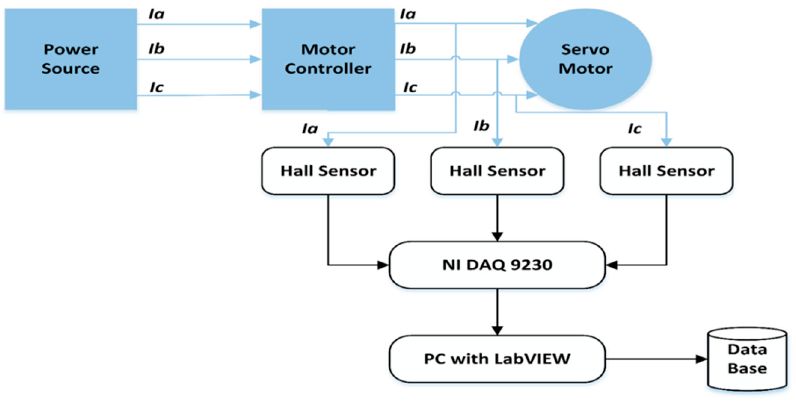
Figure 5. Block diagram of the data collection process.